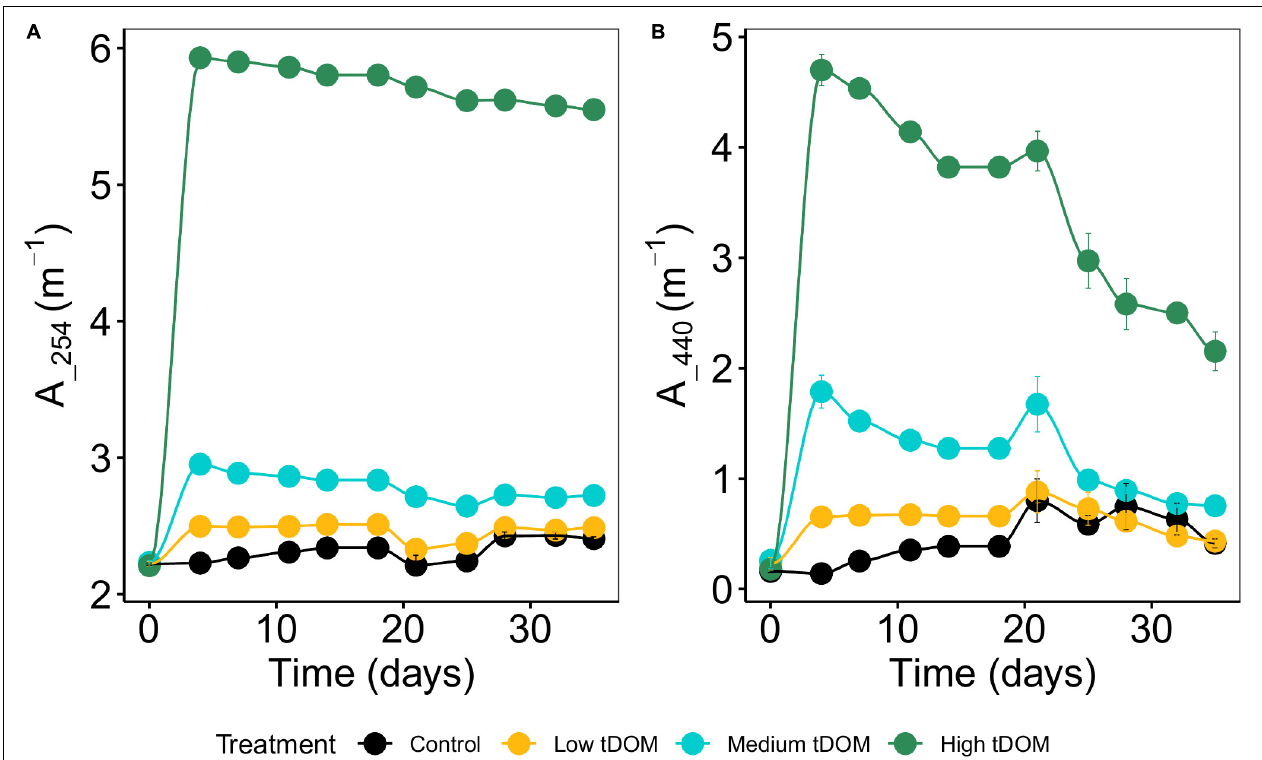
FIGURE 1 | Absorbance coefficient of tDOM (A) at 254 nm and (B) at 440 nm (shown as decadal (log 10) absorption coefficient) over 35 days of the experiments. Error bars represent standard deviation within treatment replicates. Colors represent tDOM addition: control (black), low tDOM (yellow), medium tDOM (blue), and high tDOM (green)